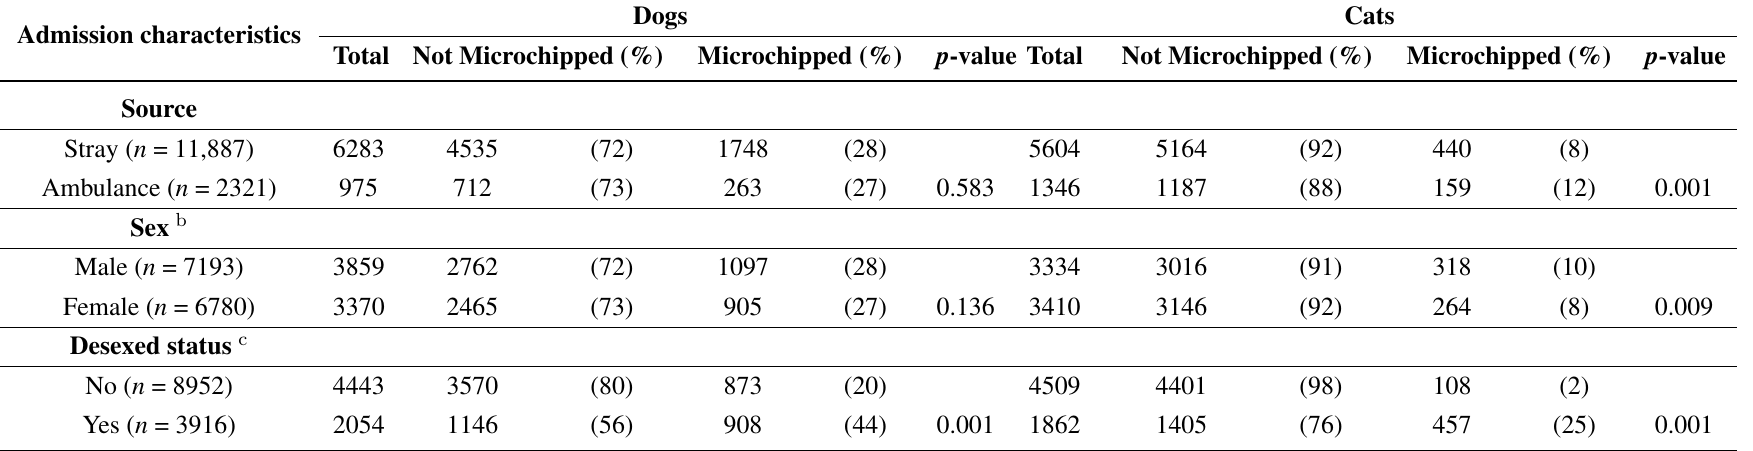
Table 2. Cross-tabulation of source, sex and desexed status for non-microchipped and microchipped stray adult dogs and cats admitted to RSPCA-QLD shelters (January 2012–December 2013). Percentage of non-microchipped and microchipped animals for source, sex and desexed status is shown in